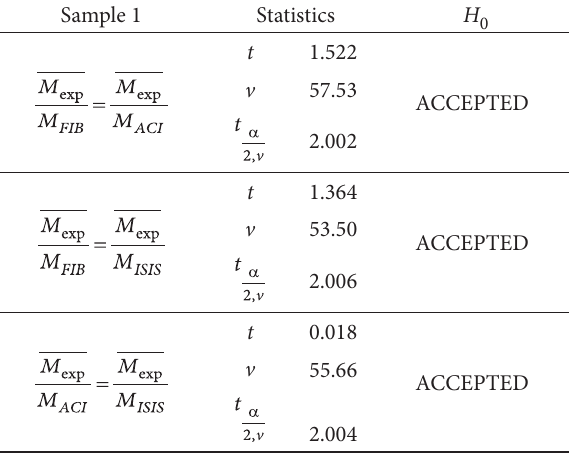
Table 4. Results of t test of sample 1 Sample 1